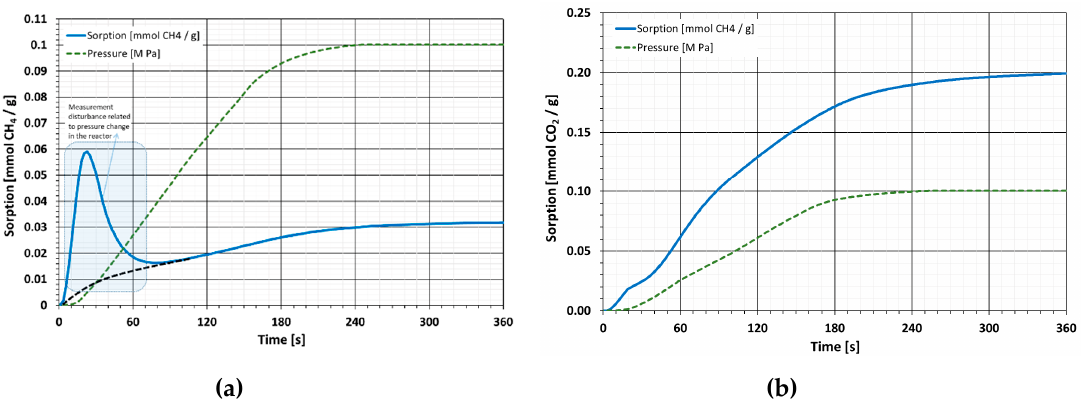
Figure 12. Di ff usion kinetics of C-HAL calcined halloysite: ( a ) di ff usion kinetic of CH 4 ; ( b ) di ff usion kinetic of CO 2 .